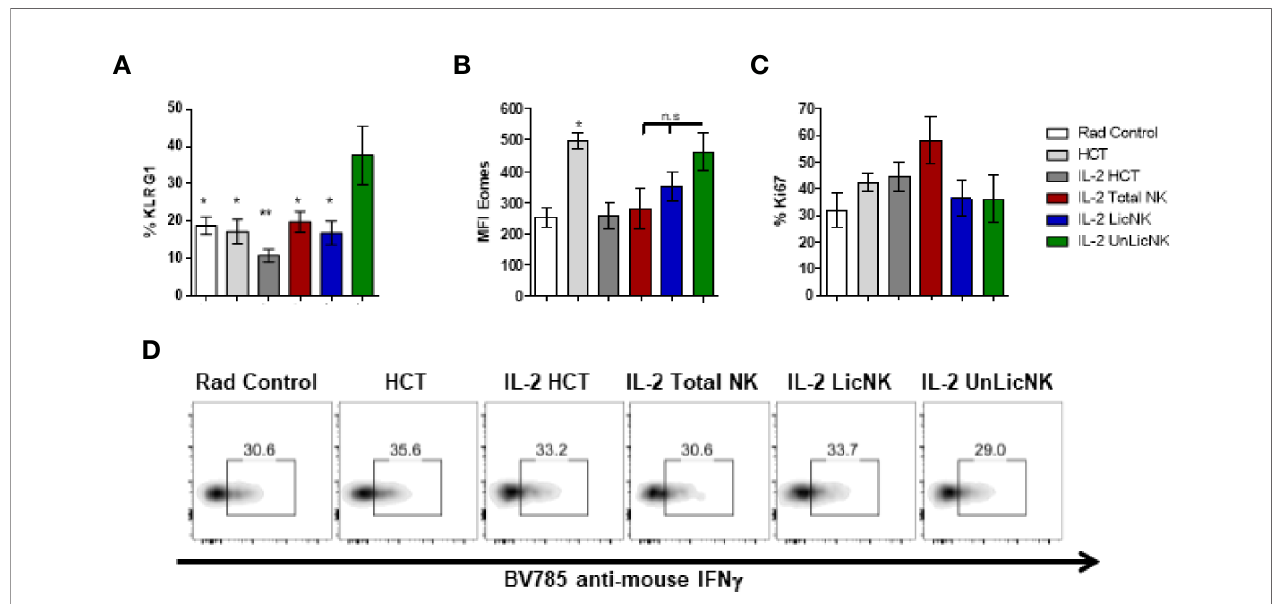
FIGURE 4 | NK cell activation status during NMAC HCT. (A) The percentage of KLRG1 is shown for gated total (H2b/d) NK cells (CD3 - CD49b + ). (B) MFI expression of the activating transcription factor eomes is shown for total NK cells (D) . (C) Percentage of Ki67 for gated total NK cells is shown. (D) Representative dot-plots of IFN g + cells on gated total NK cells after stimulation with anti-NK1.1. Data is representative of two independent experiments with n=3 – 5 per group (mean ± SEM). One-way ANOVA was used to assess signi fi cance. (*p<0.05, **p<0.01, n.s, no signi fi